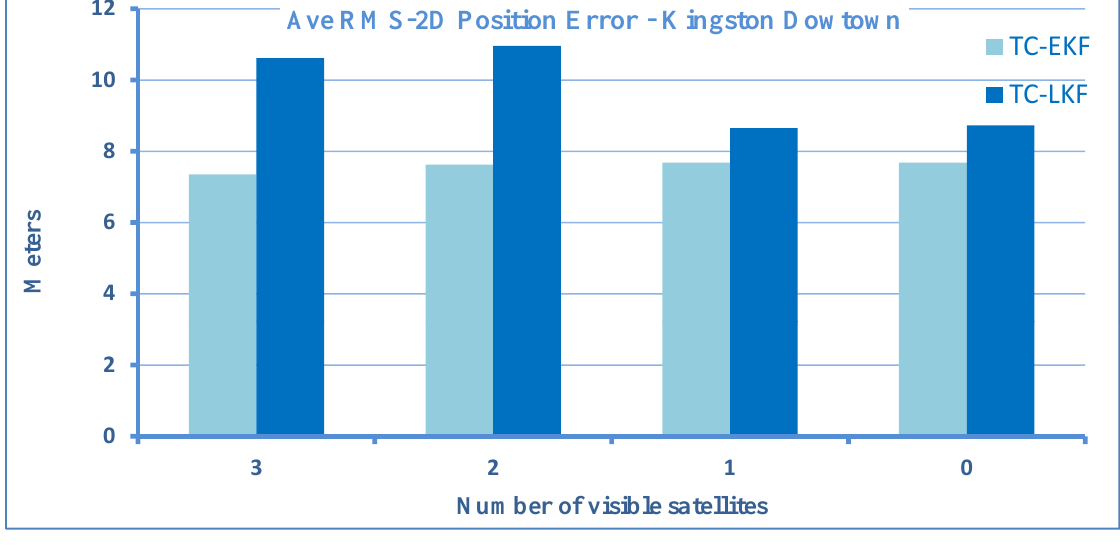
Figure 9. A comparison of TC-EKF with TC-LKF for the average RMS 2D position error for the Kingston downtown trajectory.